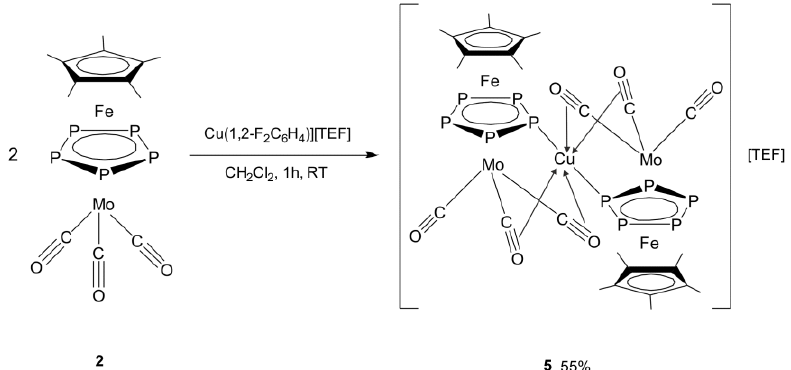
Scheme 4. The reaction of triple-decker complex 2 with Cu(1,2-F 2 C 6 H 4 )[TEF]. Synthesis of